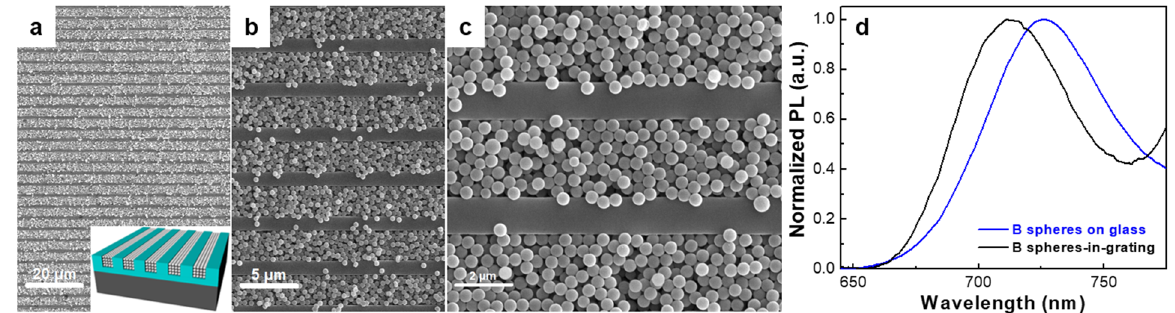
Figure 2. ( a – c ) SEM images of different magnification depicting PS spheres stained with fluorescent blue ( B ) dye and incorporated in periodic grooves of a width of 2.5 µm and a depth of 2 µm. The inset in ( a ) schematically depicts the expected sphere-in-grating assembly structure. ( d ) Normalized PL spectra illustrating a blueshift from 725 nm to 710 nm when comparing B spheres spin-cast on glass to those incorporated in the grating. An excitation wavelength of 410 nm was used.